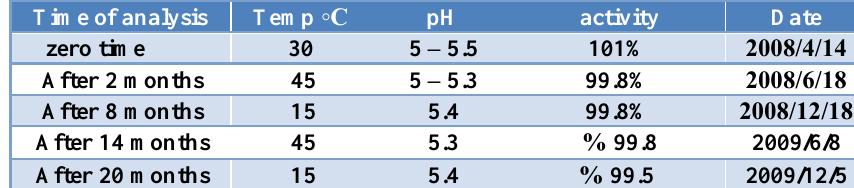
Table, 4: Results of chemical